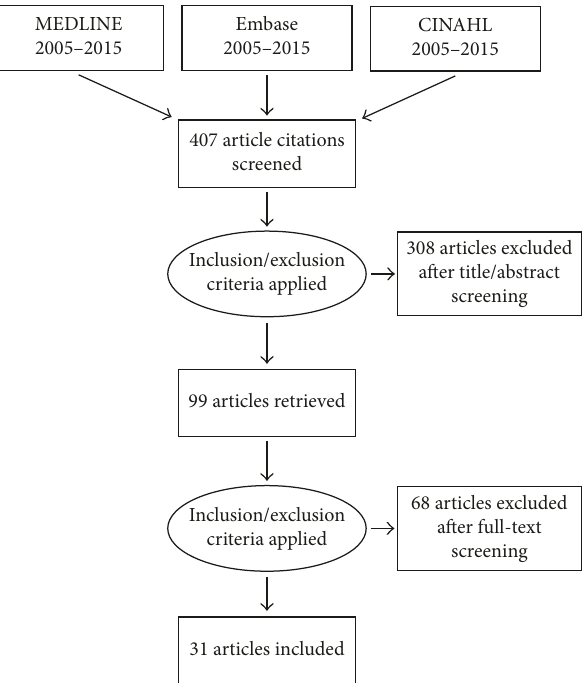
Figure 1: Summary of literature search and included